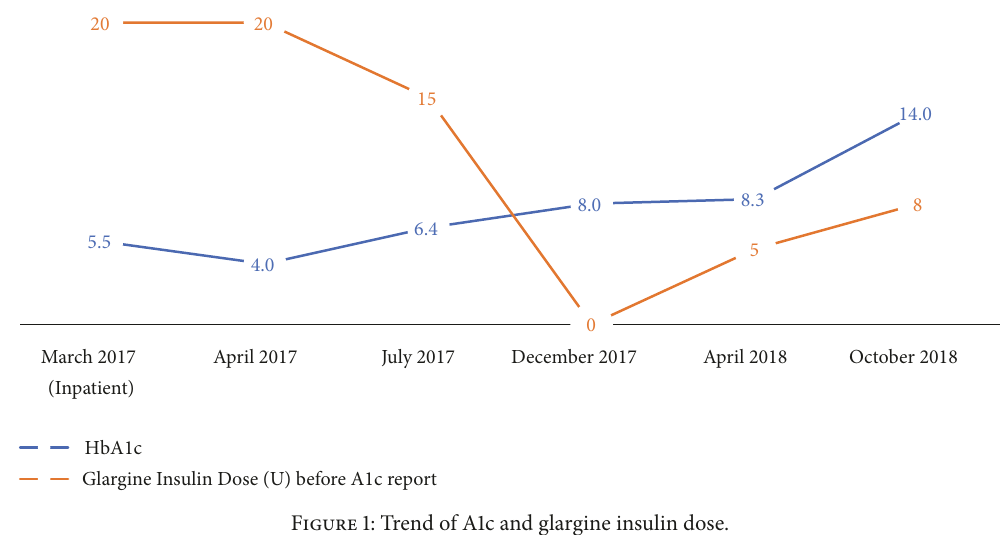
Figure 1: Trend of A1c and glargine insulin dose.